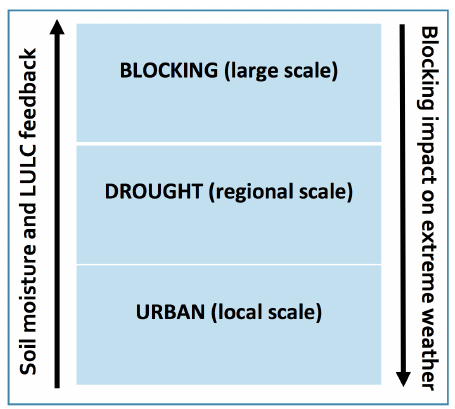
Figure 12. Schematic illustration of the dynamical linkage and feedback among atmospheric blocking, drought, heatwave and urban heat island across multiple scales. Here land use land change is shortened for